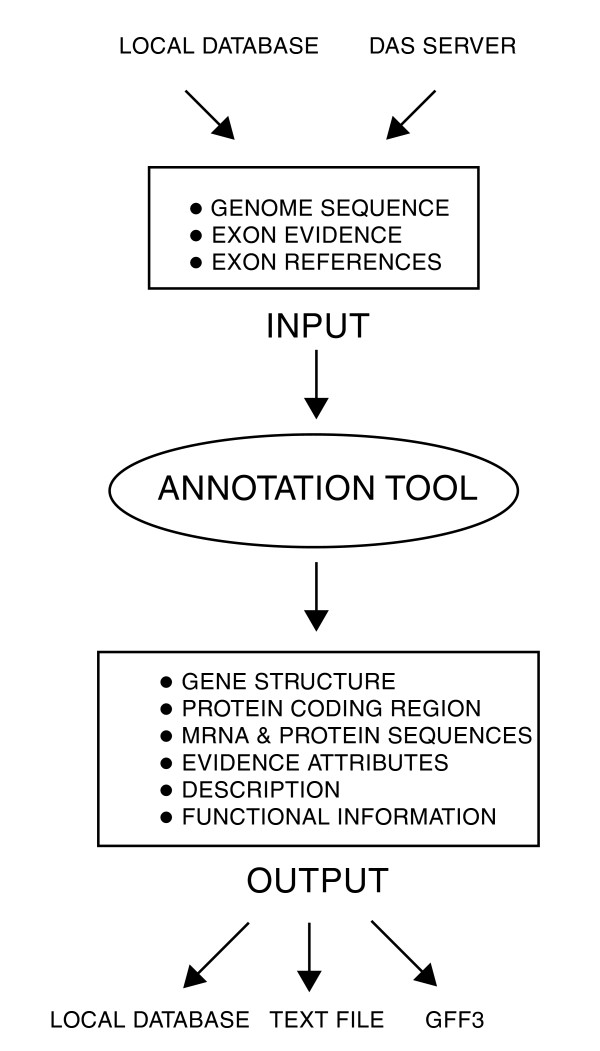
The applications interface of yrGATE. Input to yrGATE is derived from either local database tables or distributed DAS sources. Output is either to local database tables or in the form of simple text or GFF3 files.